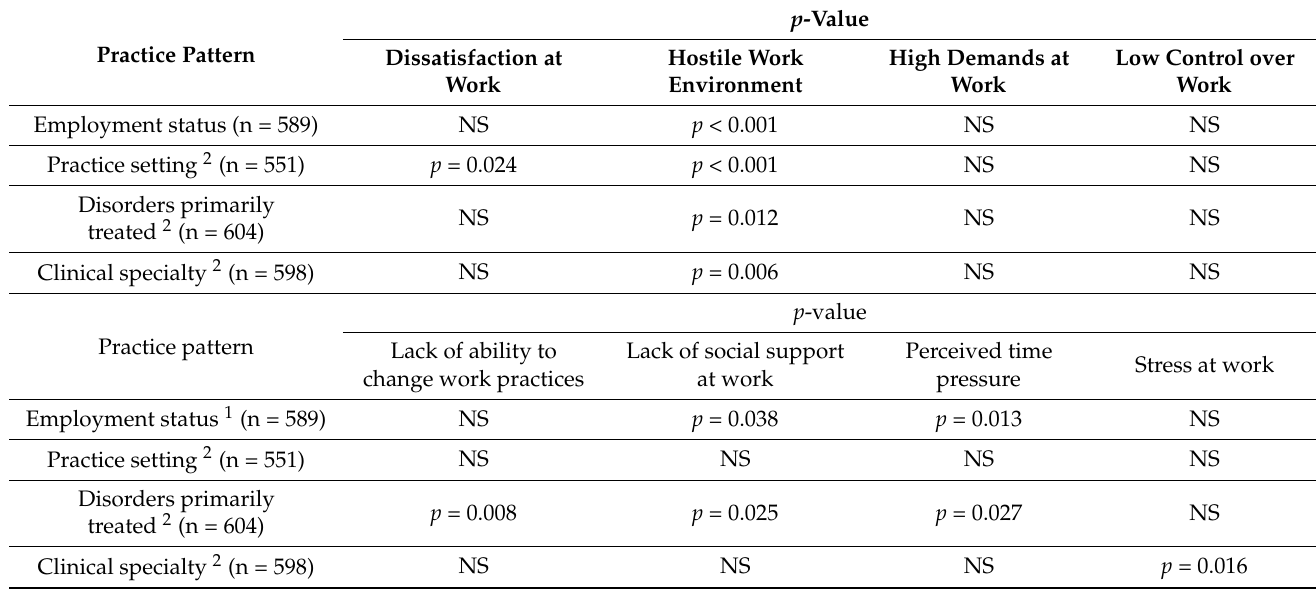
Table 4. Results of statistical tests for exposure to psychosocial and organisational risk factors, as a function of practice